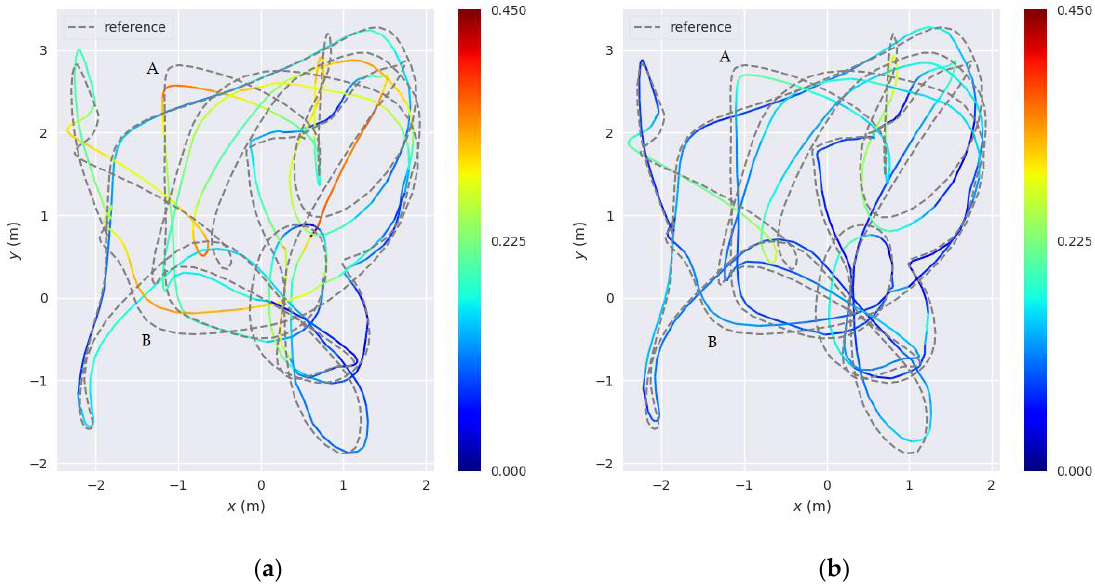
Figure 6. Positioning accuracy heat maps of the two error models. ( a ) The resulting trajectory of the traditional error model used in reference SLAM system; ( b ) The resulting trajectory of the extended error model used in our proposed SLAM system. The gray dotted line represents the ground-truth. The color solid lines represent the accuracy of the trajectories. A change in color from blue to red indicates a gradual increase in the positioning error.